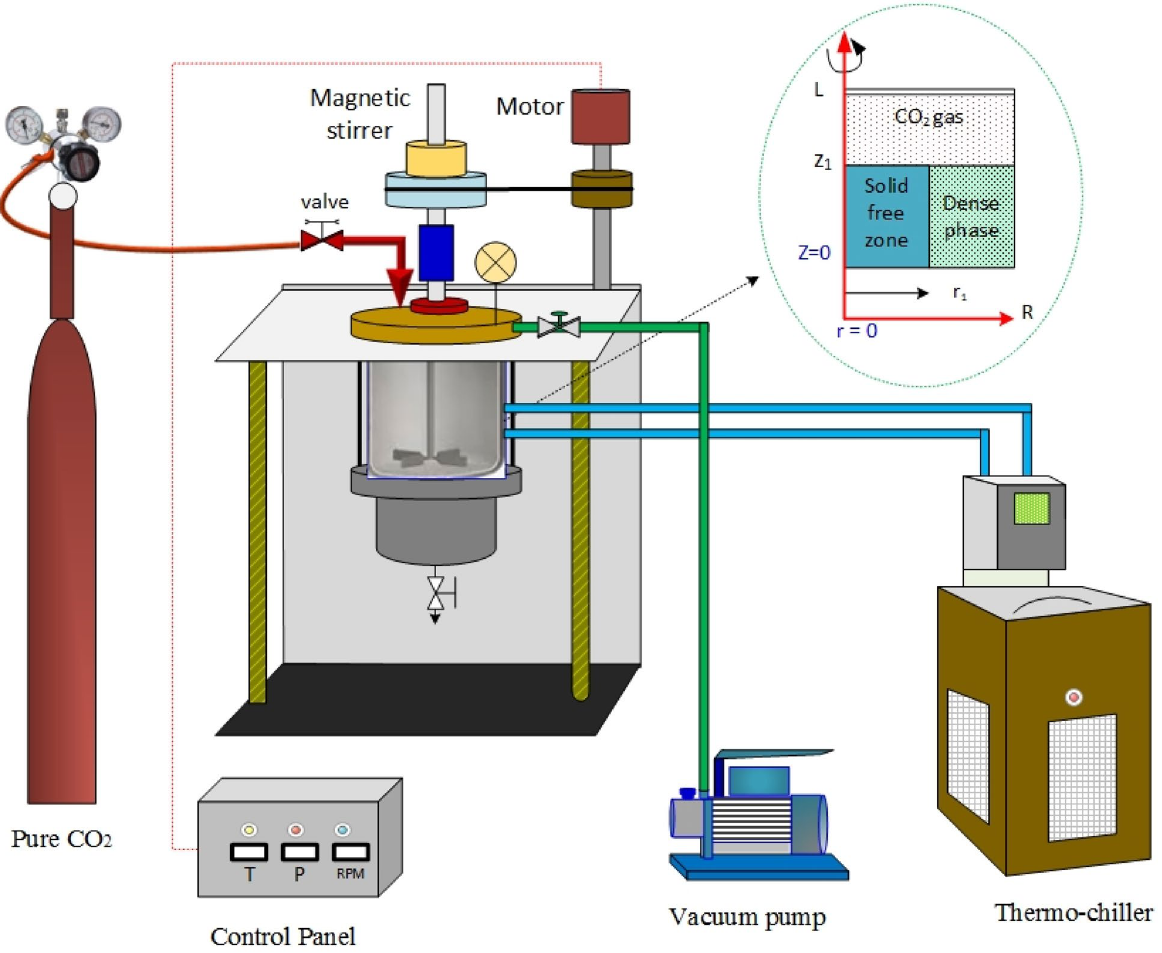
Figure 1. Schematic of the experimental setup and the modeling zone used for the absorption of CO 2 by nanofluid in a high-pressure stirred cell. Figure generated using Microsoft Visio Professional 2016 (Microsoft.